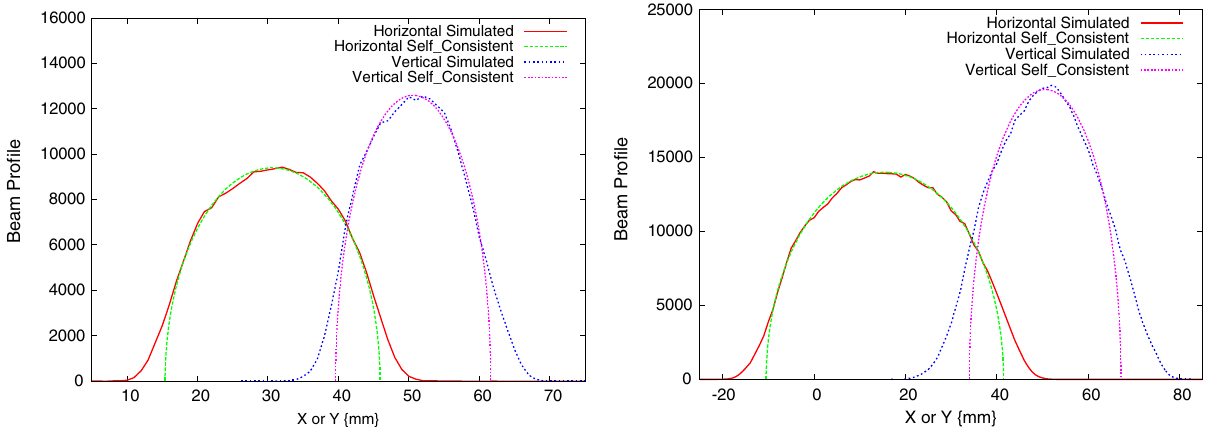
FIG. 11. Horizontal and vertical beam profiles taken after 120 (left) and 300 turns (right) of accumulation. Mathematically ideal profiles for self-consistent beams are overlaid on the simulation results.